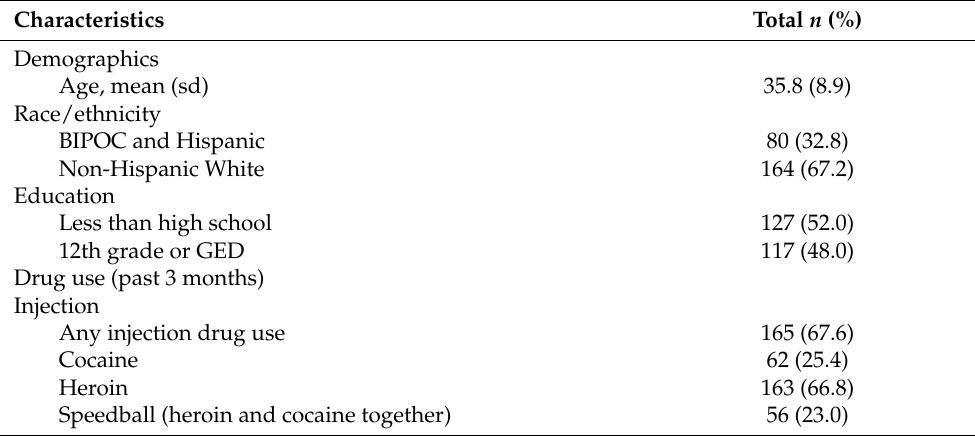
Table 1. Sociodemographic characteristics, drug use indicators, and study outcomes among women engaged in transactional sex in Baltimore